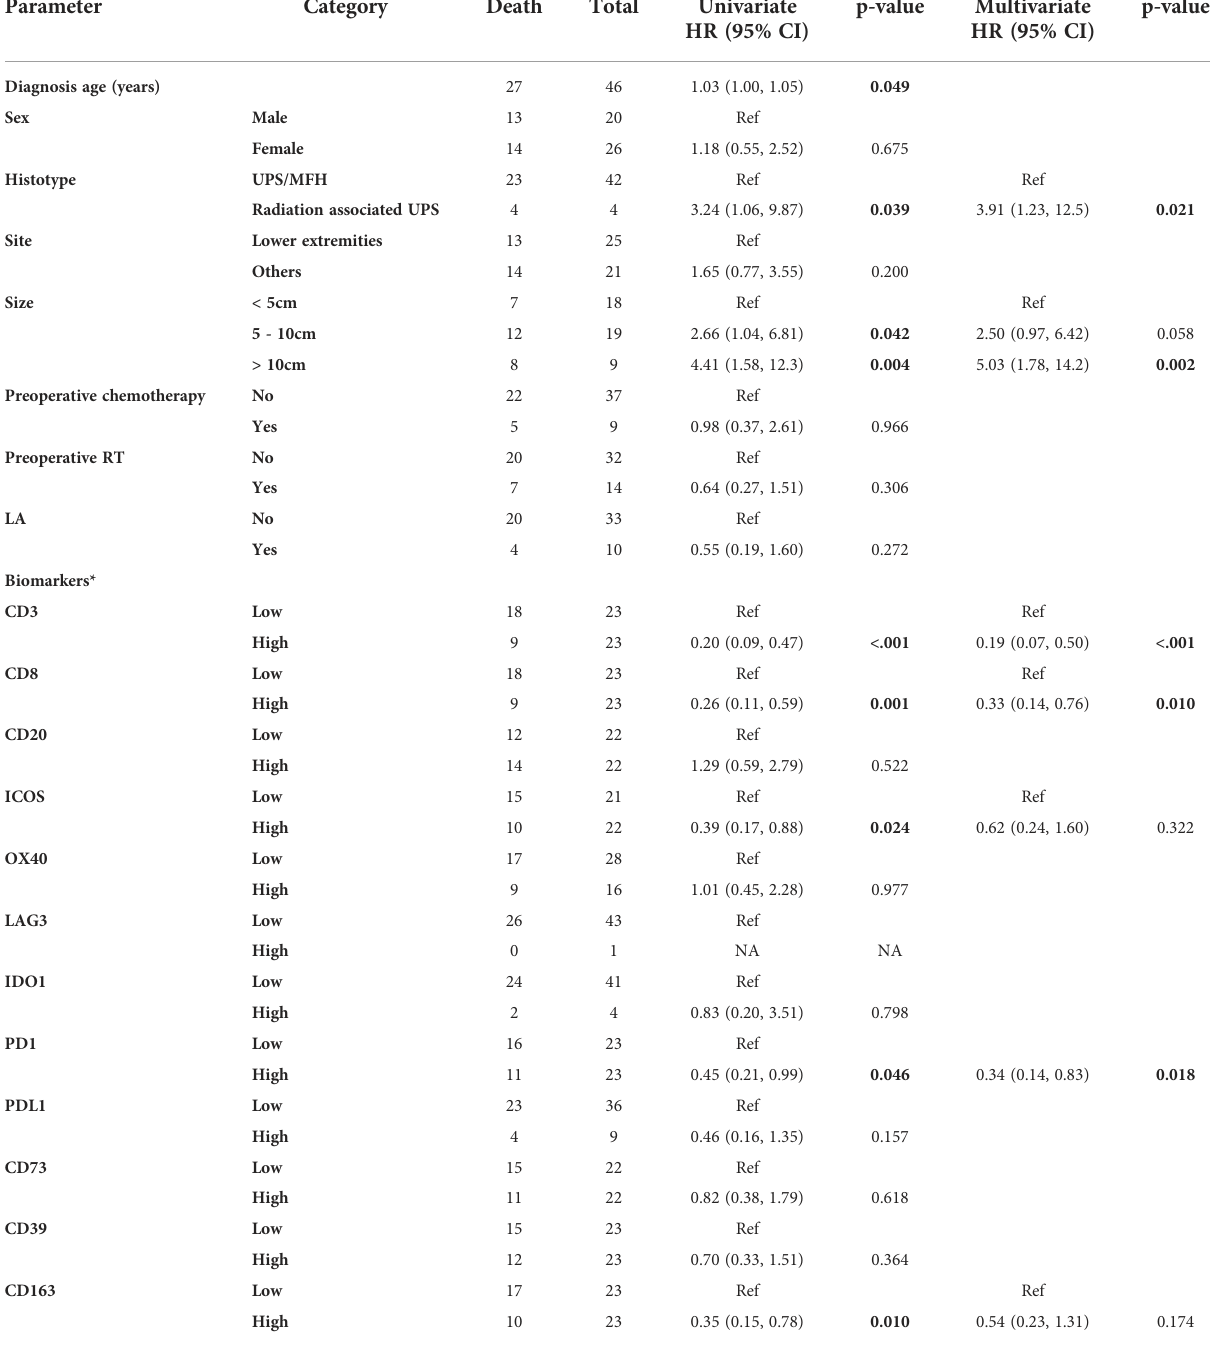
TABLE 4 Univariate and multivariate cox analyses for overall survival in primary